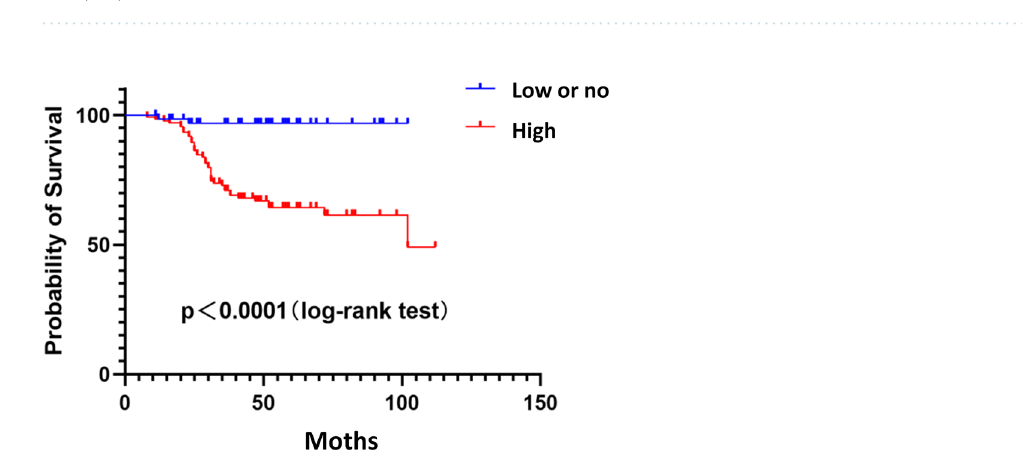
Figure 2. Survival curves of BC